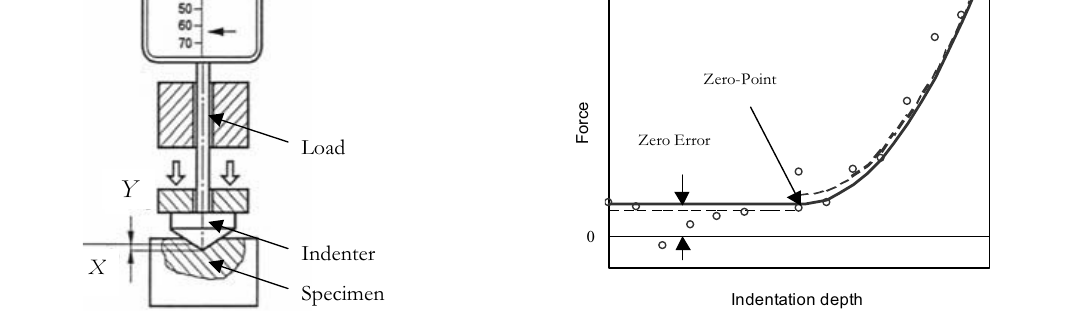
Figure 1 – Scheme of a hardness measuring machine.